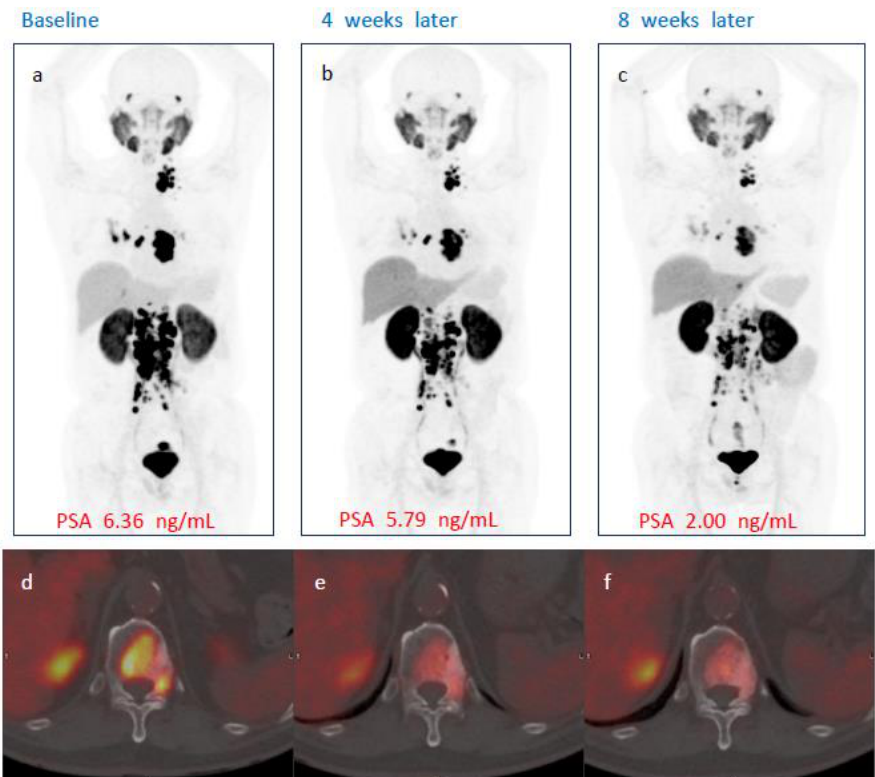
Figure 3. A case of a subject showing PSA response to [ 177 Lu]Ludotadipep. ( a , d ) Baseline [ 18 F]Florastamin PSMA PET/CT maximum intensity projection (MIP) and fused axial images with multiple bone and lymph node metastases. ( b , c ) PSMA PET/CT MIP images at four and eight weeks after administration of [ 177 Lu]Ludotadipep showing decreased tumor burden. ( e , f ) Axial fused PSMA PET/CT images at four and eight weeks show decreased uptake in metastatic lesion in the thoracic vertebra. The patient’s PSA decreased from 6.36 to 2.00 ng/mL at 8 weeks.